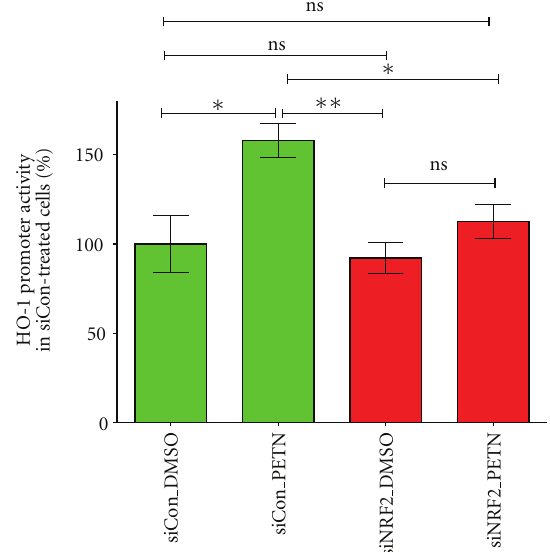
Figure 6: PETN-induced enhancement of the human HO-1 promoter activity depends on NRF2. DLD1-HO-11kb-Prom cells were transfected with a specific anti-NRF2 siRNA (siNRF2) or a nonrelated control siRNA (siCon). After 48 h, the cells were incubated with PETN or the solvent DMSO. Extracts were prepared and luciferase activity and protein content were measured, and luciferase activity was normalized to the protein content. Shown (mean ± SEM; n = 5-6) are the normalized luciferase activity values. The normalized luciferase activity of the cell treated with solvent and siCon was set to 100%. ( ∗∗ = P < 0 . 01, ∗ = P < 0 . 05, ns: not significant di ff erent to DMSO and siCon-treated cells. Modified from